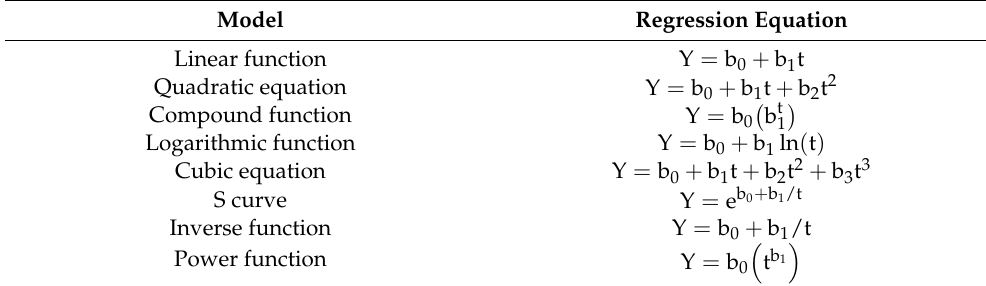
Table 6. Different models for curve